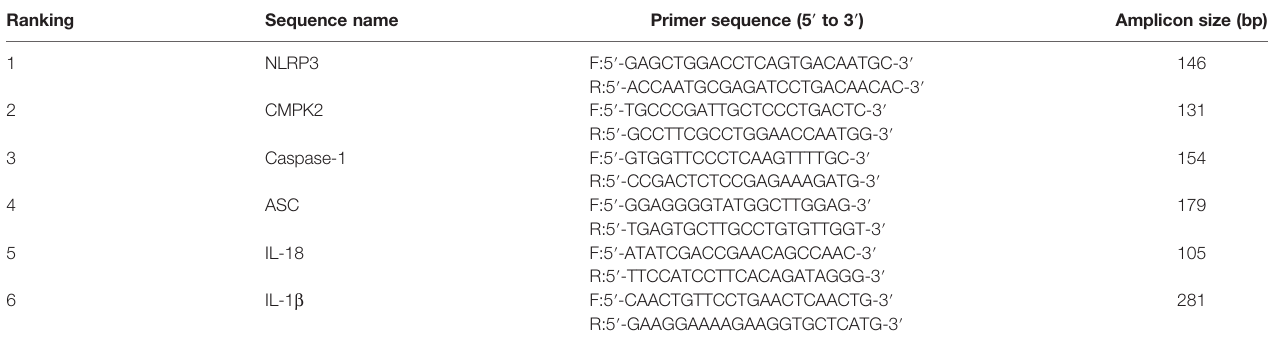
TABLE 1 | Sequences of the primers used for